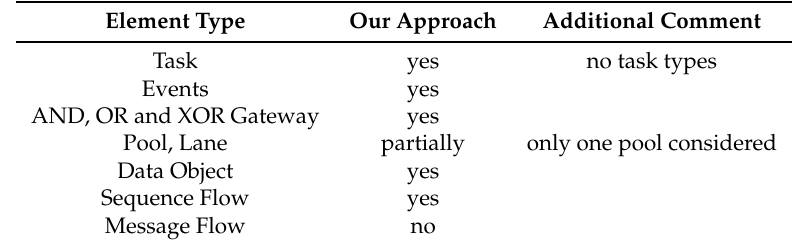
Table 4. A concise overview of elements that can be modeled within the proposed solution.